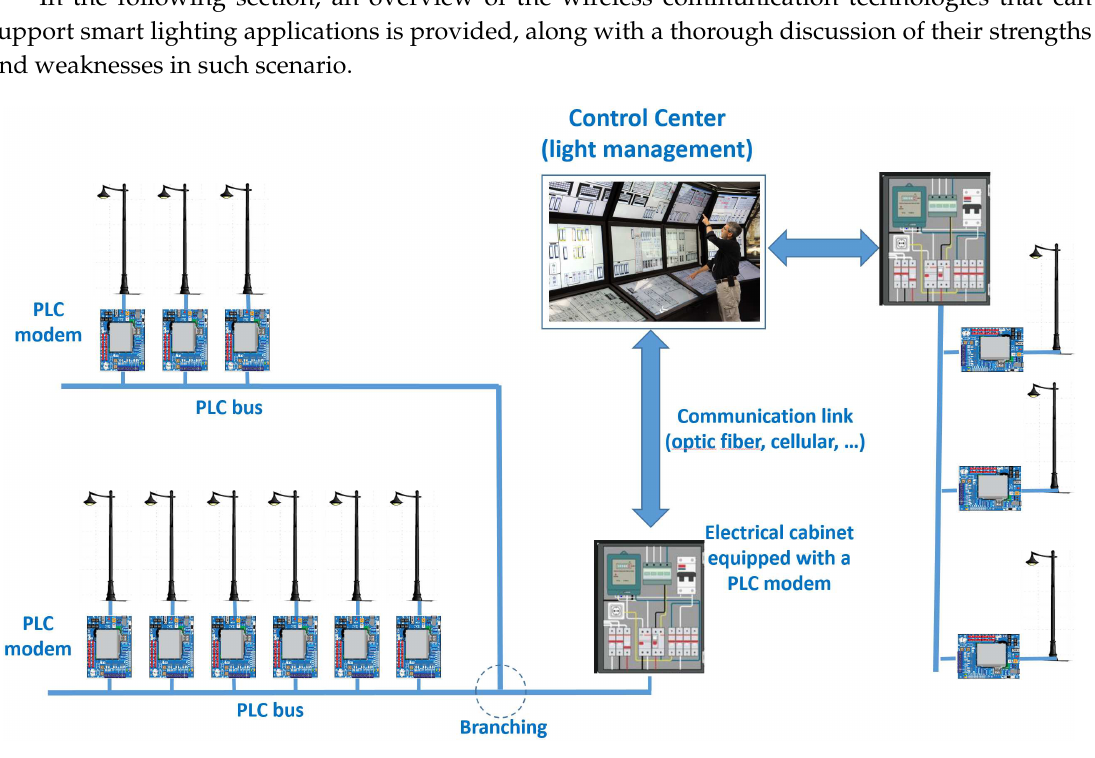
Figure 2. PLC-based smart lighting